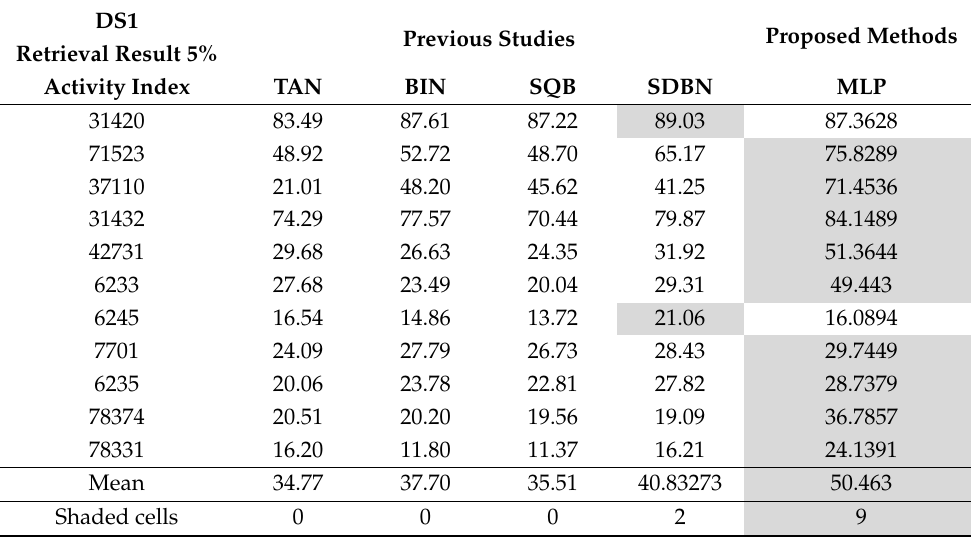
Table 7. Retrieval results of top 5% for MDDR-DS1 dataset for (ECFC_4) descriptor.